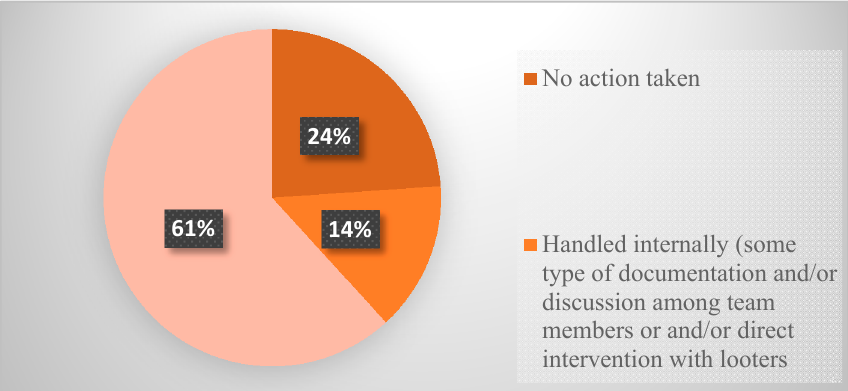
Figure 3. Actions taken by archaeologists upon observance of looting, in aggregate.